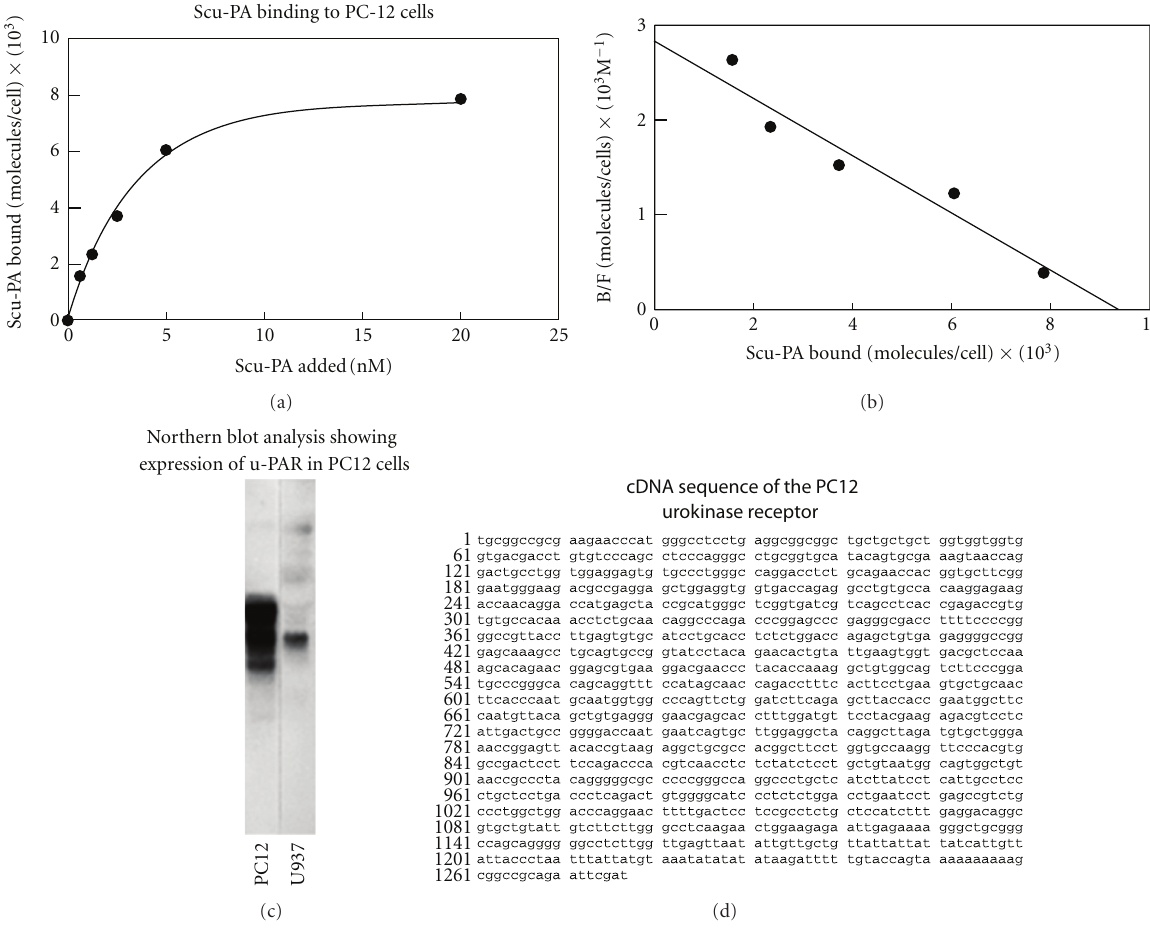
Figure 2: Expression of uPAR by PC12 cells. (a) Binding isotherm of 125 I-scu-PA to PC12 cells. Cells in suspension were incubated with 125 I-scu-PA, and bound ligand was separated from free by centrifugation over sucrose. Nonspecific binding was determined in the presence of unlabeled scu-PA. (b) Scatchard analysis of the binding isotherm in Panel A. (c) Northern blot analysis showing expression of uPAR in PC12 cells. Poly(A)-enriched RNA was isolated from PC12 cells and Northern blotted with a 458 bp SMaI+BamHI (nuc. 41–493) human uPAR cDNA probe. Northern blotting of U937 cell poly(A) RNA is shown for comparison. (d) cDNA sequence of PC12 uPAR. The rat uPAR sequence was obtained by screening a PC12 cDNA library using a 609 bp EcoRI+NcoI (nuc. 110–718) human uPAR cDNA probe labeled with [ α - 32 P]